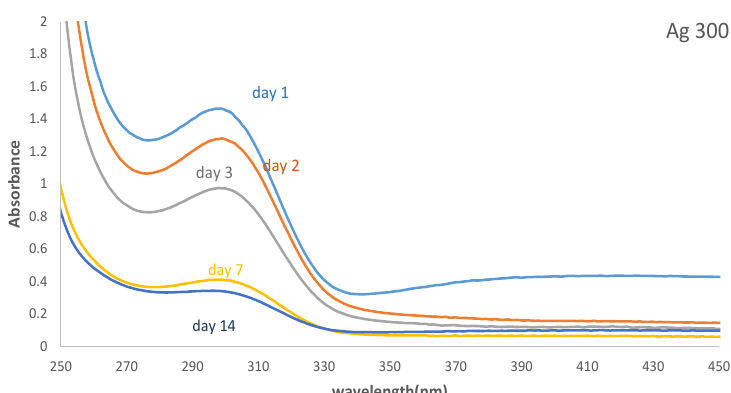
Fig. 3: The absorption spectrum of silver nanoparticles synthesized by electrochemical method at 300 second interval in the first, second, third, seventh and 14 th days (1 amp current and rotation speed of 3000 RPM).